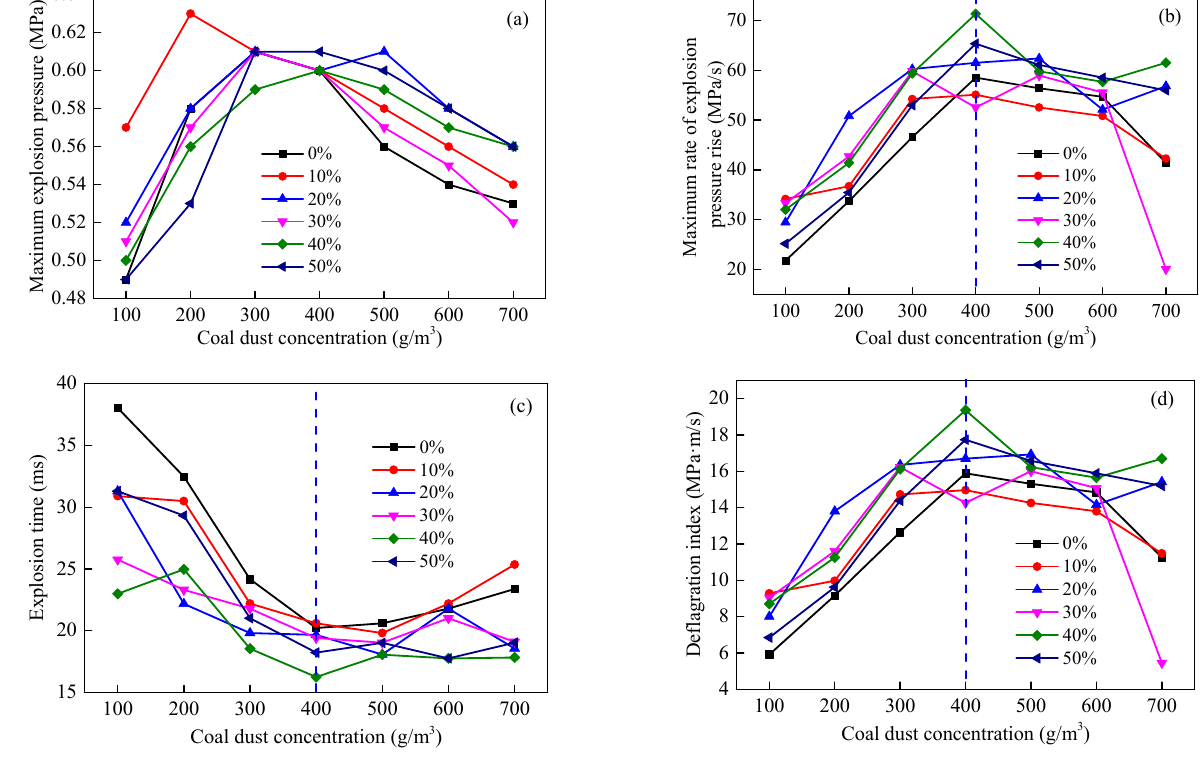
Figure 6. The maximum pressure ( a ), the maximum rate of the explosion pressure rise ( b ), the explosion time ( c ), and the deflagration index ( d ) of the explosion coal dust samples at a series of explosion concentrations.